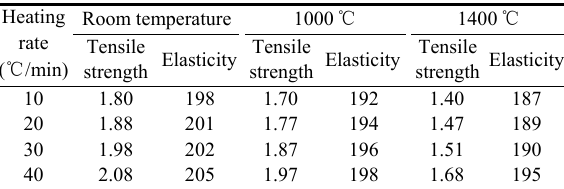
Fig. 8 (a) Tensile strength and (b) Young’s modulus of SiC fiber at different heating rates under ambient atmosphere at room temperature, 1000 ℃ , and 1400 ℃ . Table 4 Average tensile strength and elasticity of SiC fiber with various heating rates at different temperatures